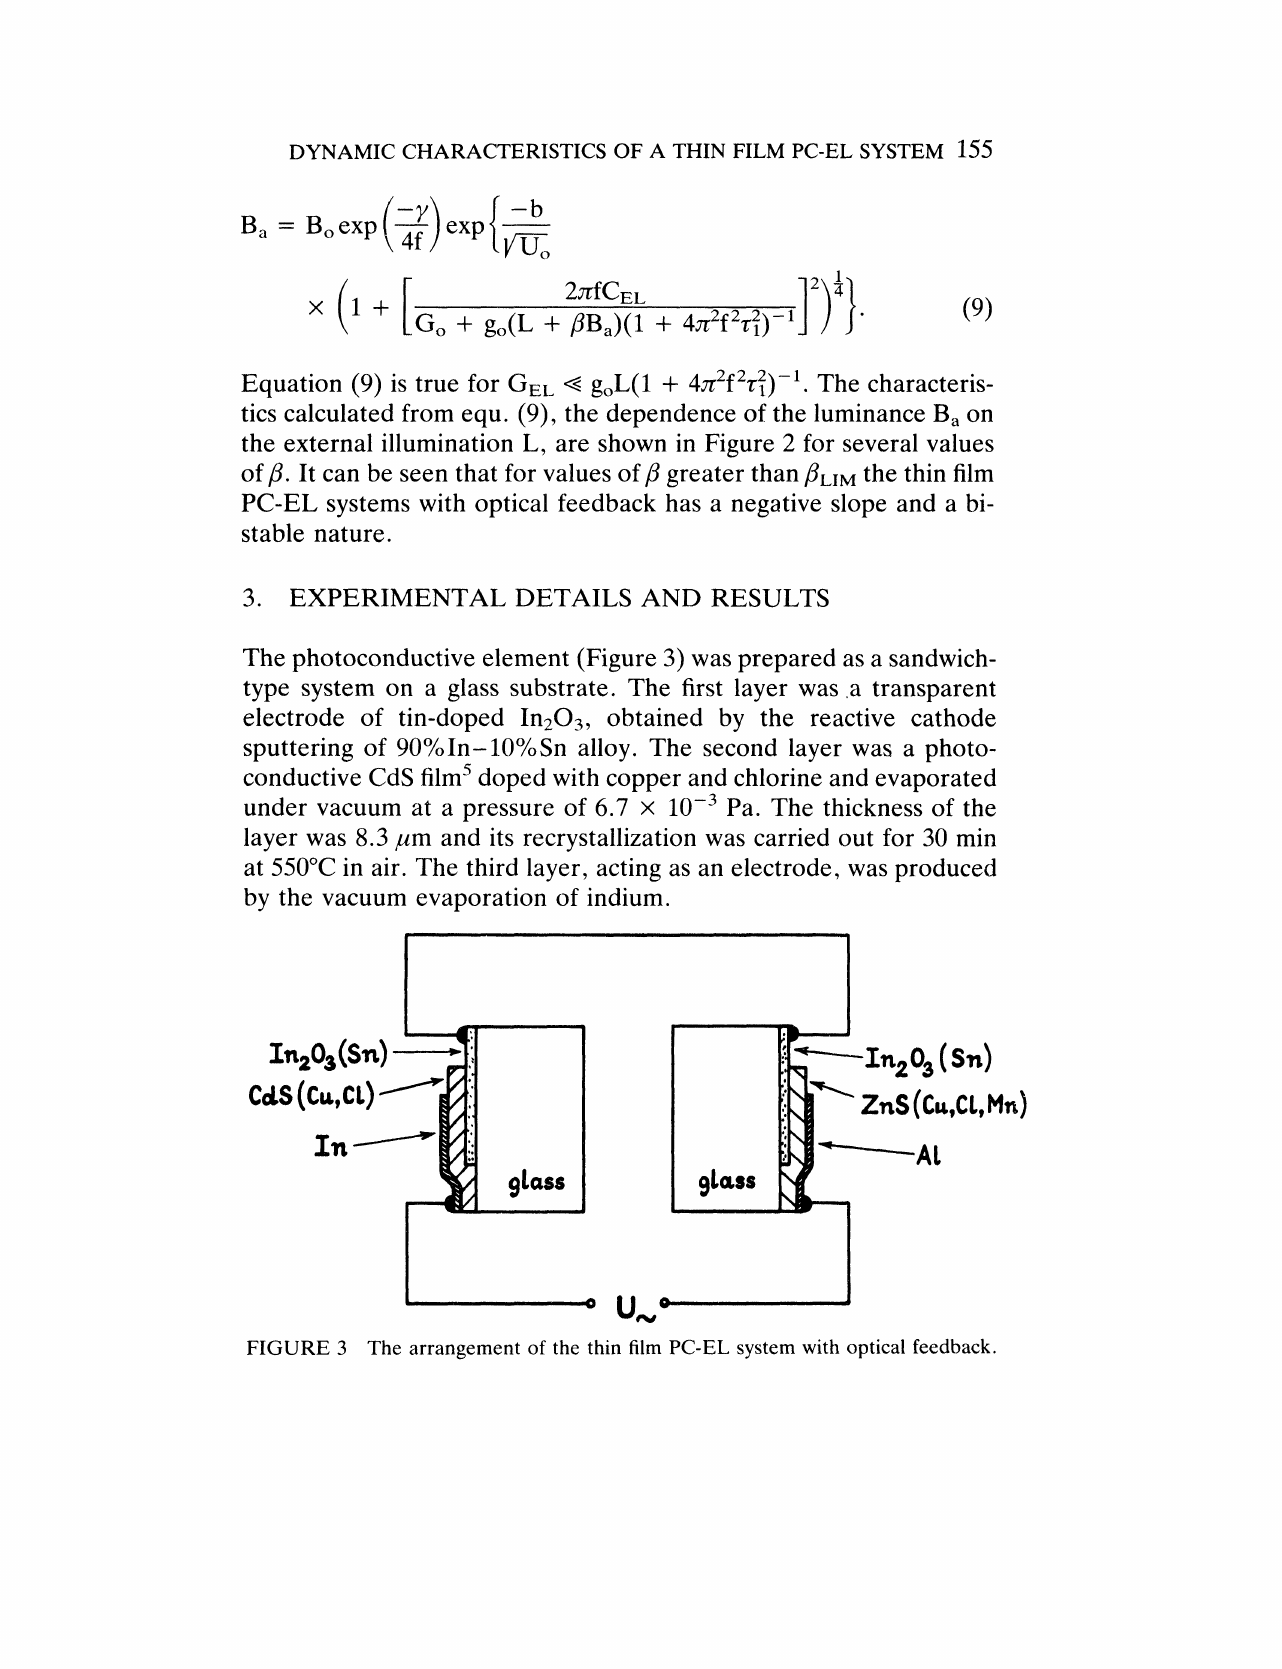
FIGURE 3 The arrangement of the thin film PC-EL system with optical